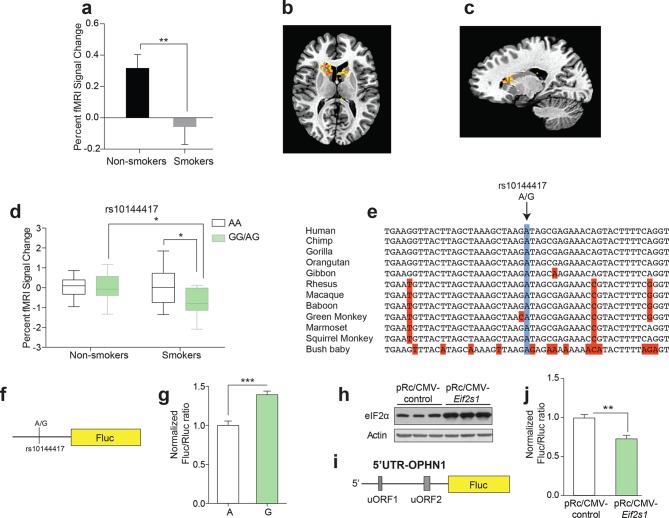
The effect of a single nucleotide polymorphism (SNP) in the promoter of the Eif2s1 gene on reward-dependent striatal activity in human tobacco smokers.(a-c) Reward-related activity in caudate/putamen is lower in smokers than non-smokers (b,
P<0.01, n=33/55, t86=2.678). (b-c) Transverse (b) and sagittal (c) views of significant fMRI BOLD signal in caudate/putamen of non-smokers compared to smokers in response to juice reward. (d) Interaction between smoking and rs10144417 genotype (P<0.05, F1,86=5.836). (e) Partial alignment of Eif2s1 promoter sequences in human and related animals. Note high level of nucleotide conservation: the rs10144417 SNP is indicated in blue and the non-conserved nucleotides in red. (f) Schematic of firefly luciferase reporter constructs, in which a 5-kb Eif2s1 promoter fragment containing either the A or G allele was cloned upstream of the firefly luciferase gene in the p15Amp reporter vector. A renilla luciferase reporter was co-transfected with reporters containing the A or G variant and firefly luciferase (Fluc) activity was normalized to renilla (Rluc) activity. (g) Effects of A and G variants of SNP rs10144417 on the transcriptional activity of the Eif2s1 promoter as assessed by a luciferase reporter assay in HEK-293 cells. The data are from three independent experiments (P<0.001, n=6 per group, t10=5.405). (h) Western blotting showing that overexpression of Eif2s1 (pRc/CMV-Eif2s1) increased eIF2α levels compared to control (vector alone pRc/CMV). (i) Diagram of the 5′ UTR-Ophn1-Fluc reporter, which consists of the 5’UTR of Ophn1 mRNA fused to the coding region of Firefly luciferase (Fluc). A renilla luciferase (Rluc) reporter vector was co-transfected into HEK293T as a transfection control. (j) Overexpression of Eif2s1 reduced expression of 5′ UTR-Ophn1-Fluc (P<0.01, n=6, t10=3.9425).